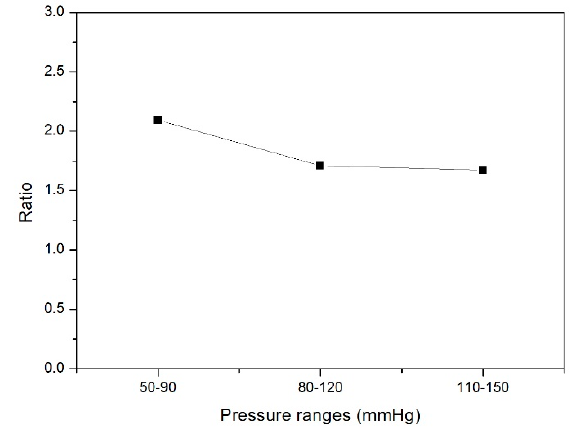
Figure 16. Ratio of compliance between G3 and S3 of nitinol-PU stent graft.